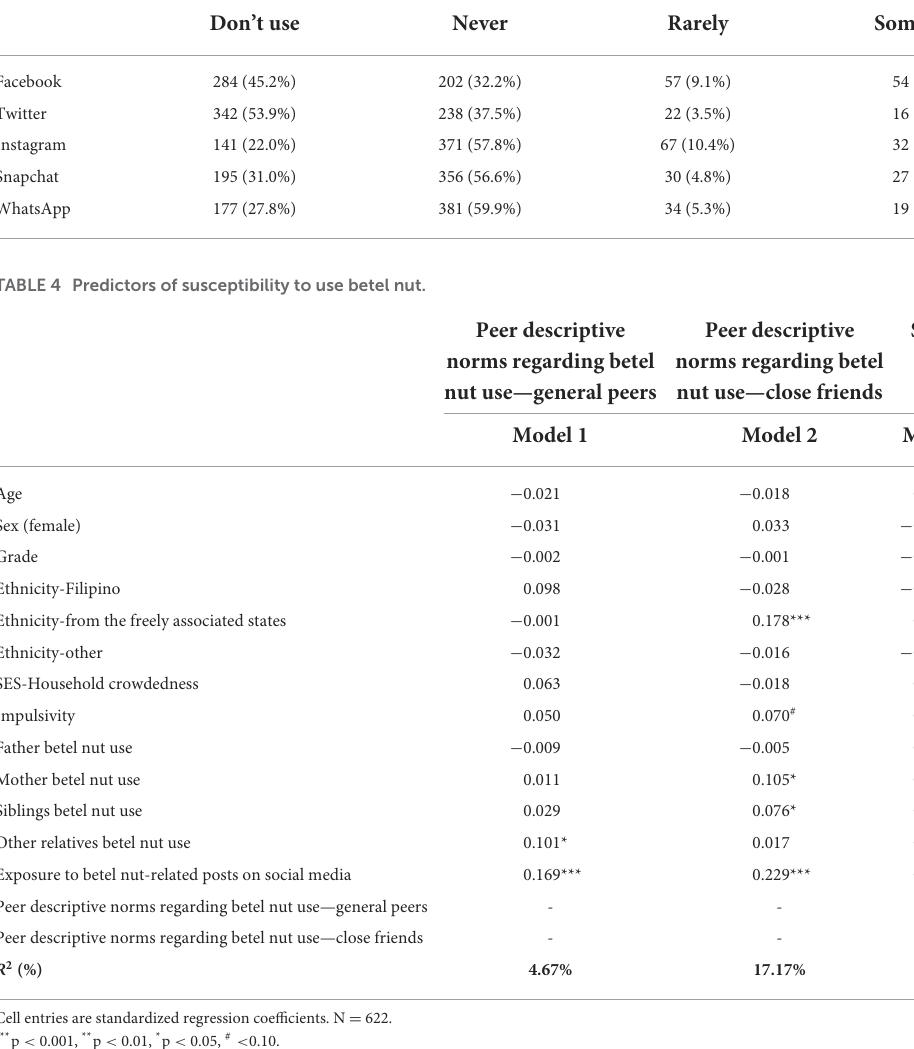
TABLE 3 Frequency of exposure to betel nut posts on social media.